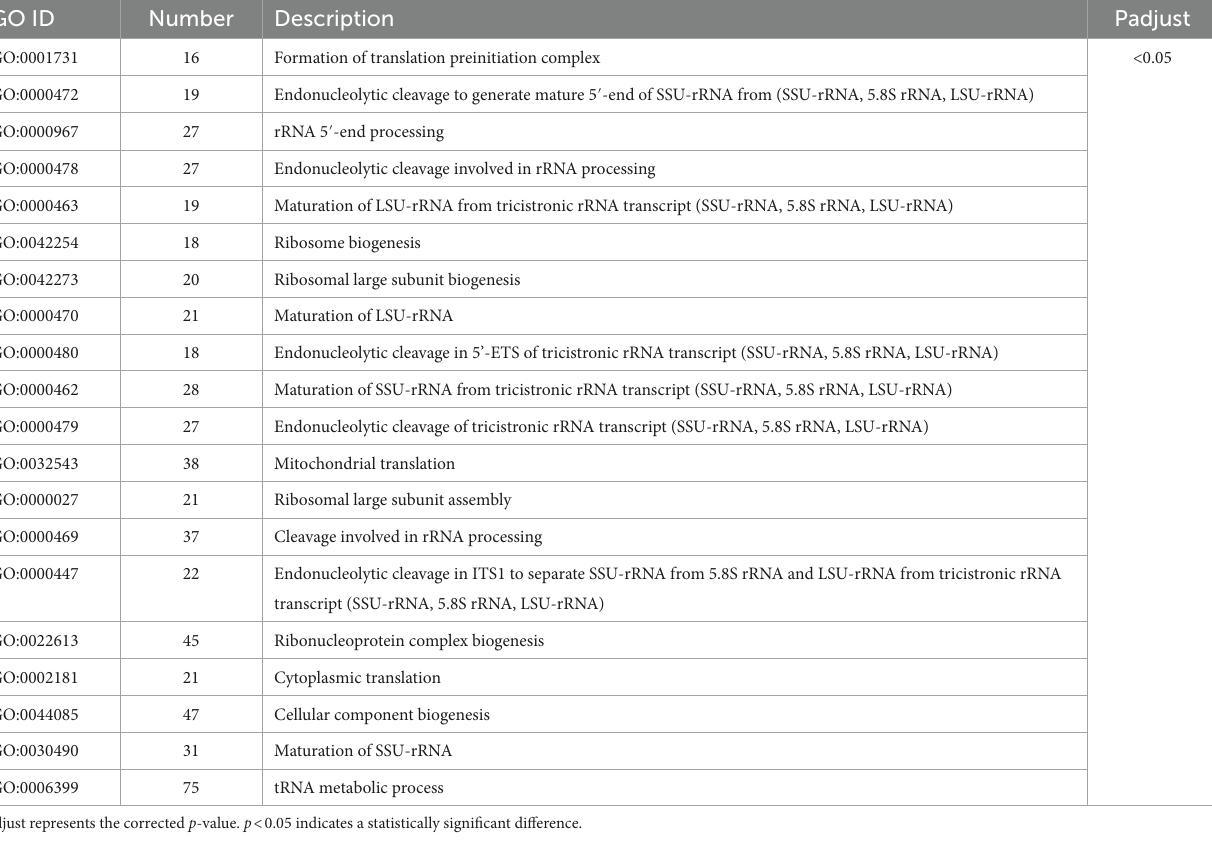
TABLE 3 Top 20 GO terms in the